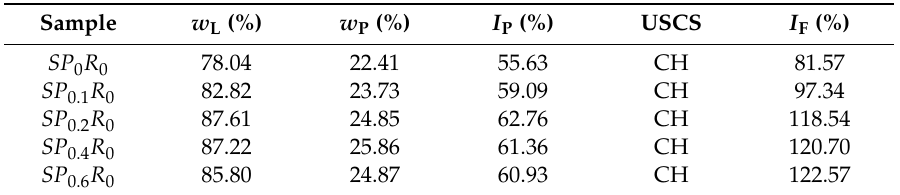
Figure 3. Flow curves for the natural soil ( SP 0 R 0 ) and the sample treated with 0.6 g / L PAM ( SP 0.6 R 0 ). Table 4. Summary of the consistency limits for the natural soil and various PAM-treated blends— SP x R 0 where x = {0, 0.1, 0.2, 0.4,